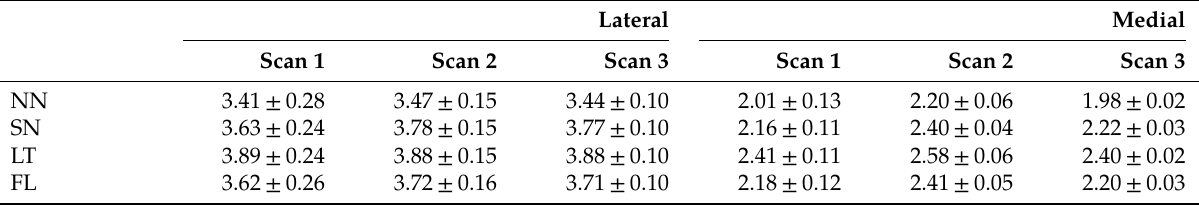
Table 2: Mean thickness values (mm) of the methods with standard